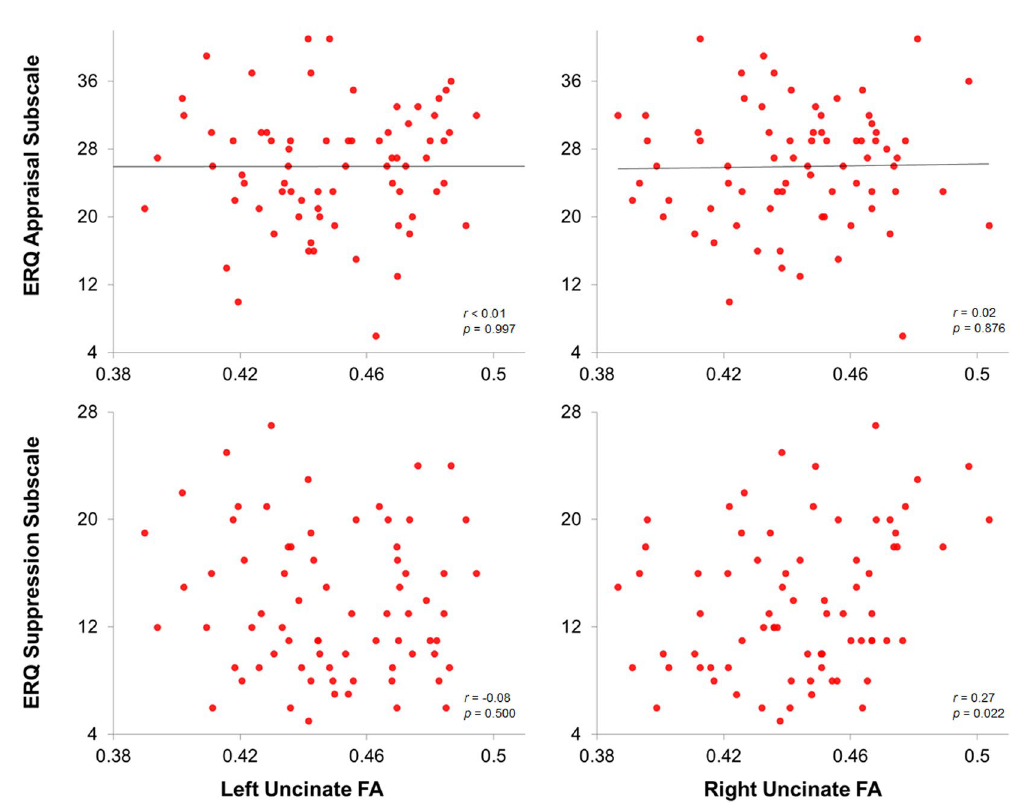
Figure 1. Relations between fractional anisotropy FA of the uncinate fasciculi and trait usage of emotion regulation strategies. Lines of best fit are included for the normally distributed data that was tested using Pearson correlation. Spearman correlation was used for non-normally distributed data. FA of the right uncinate was significantly positively correlated with Emotion Regulation Questionnaire (ERQ) Suppression ( r s = 0.27, p = 0.022), but not with reappraisal ( r p = 0.02, p = 0.876). FA of the left uncinate was not significant correlated with suppression ( r s = − 0.08, p = 0.500) or cognitive reappraisal ( r p < 0.01, p =